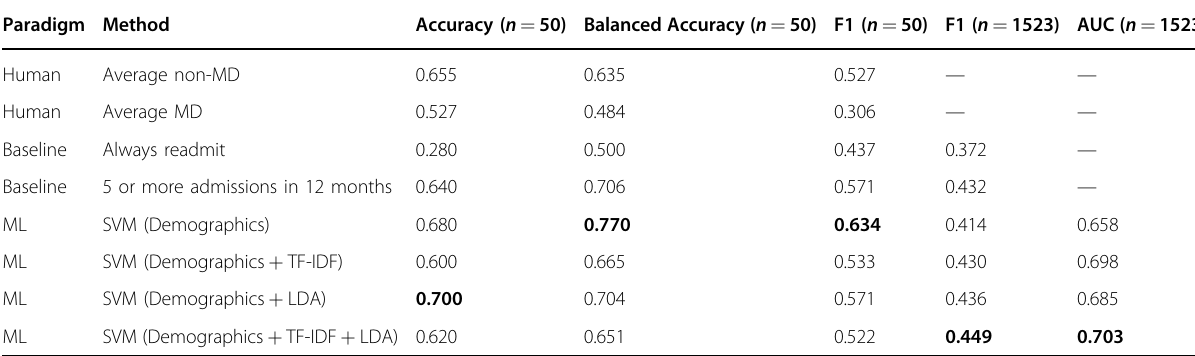
Table 3 Performance comparison between humans and predictive models on the full test set ( n = 1523) and the human- annotated learning-phase subset ( n =